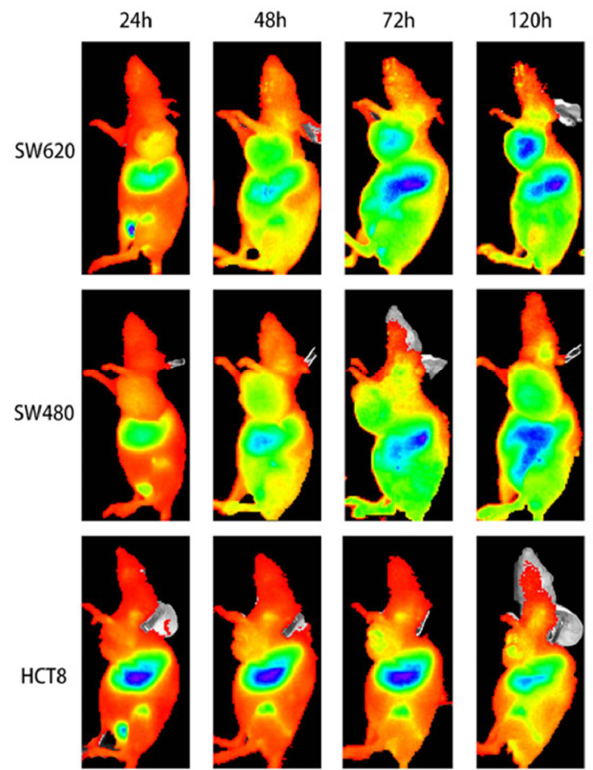
Figure 5. NIR-PD-L1 mAb specifically binds to PD-L1 in human colorectal cancer xenografted mice. Optical images in SW620-, SW480-, and HCT8-grafted mice at different time points. The figure is reproduced with permission from [47].